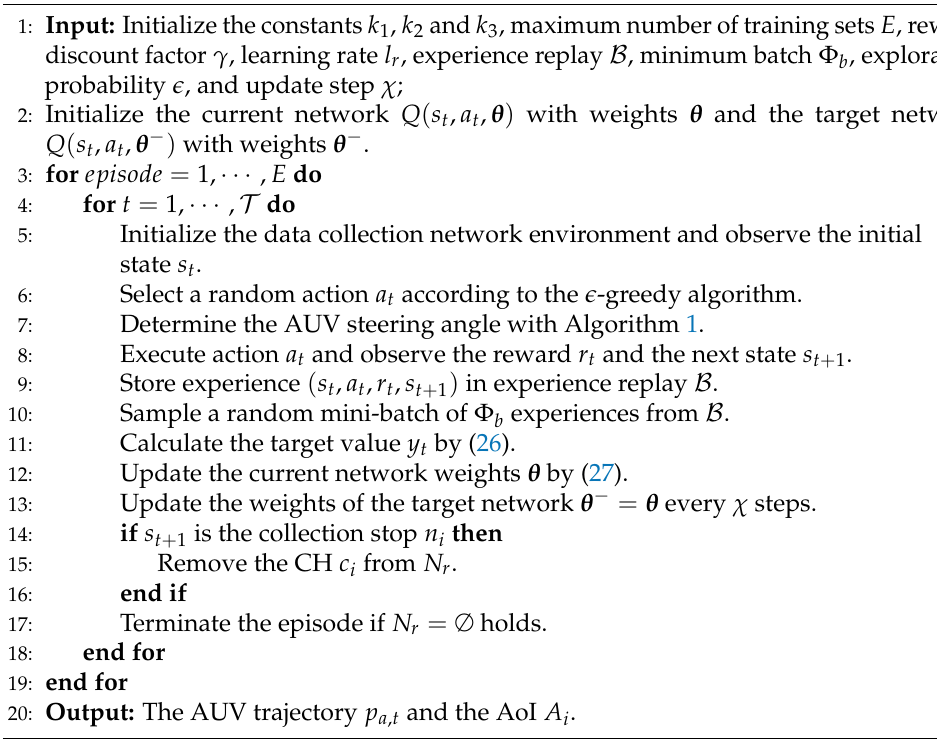
Algorithm 2 DRL-Based Multi-Modal Data Collection